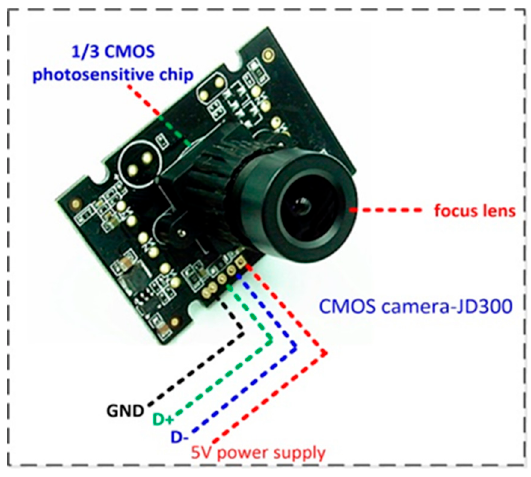
Figure 3. Camera printed circuit board details.